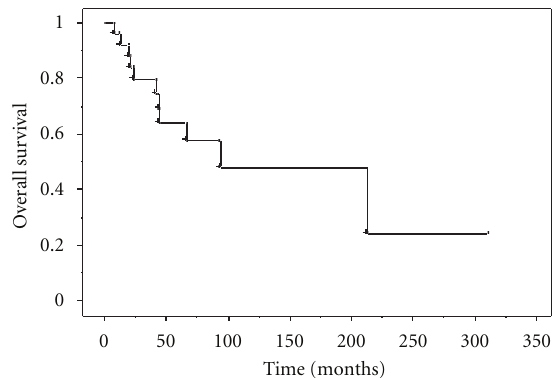
Figure 1: Kaplan-Meier plots showing overall survival of the 26 patients with